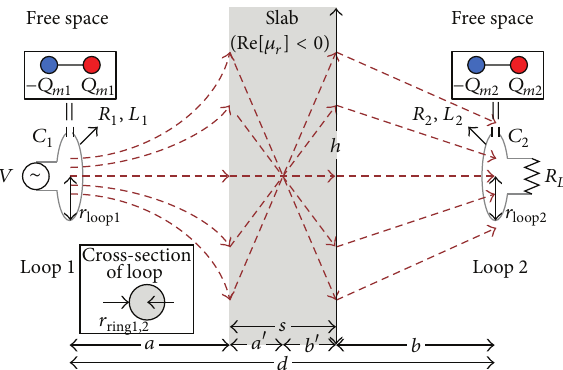
Figure 1: Magnetically coupled WPT system using two loops and a metamaterial slab.